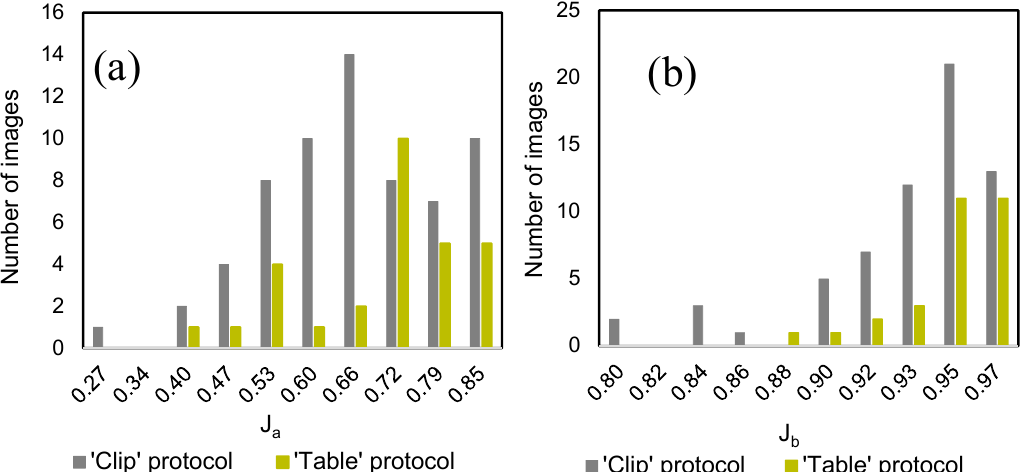
Figure 6. Distribution of the Jaccard indices, J, for ( a ) awns and ( b ) spike body grouped according to the used protocols (‘clip’ or ‘table’).